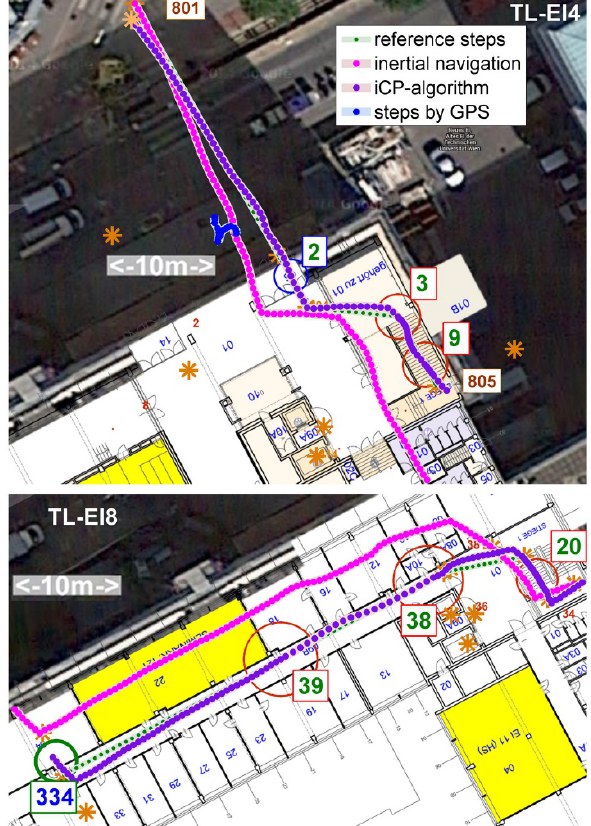
Figure 7. Complete simulation of navigation with a smartphone for two test runs TL-EI4 and